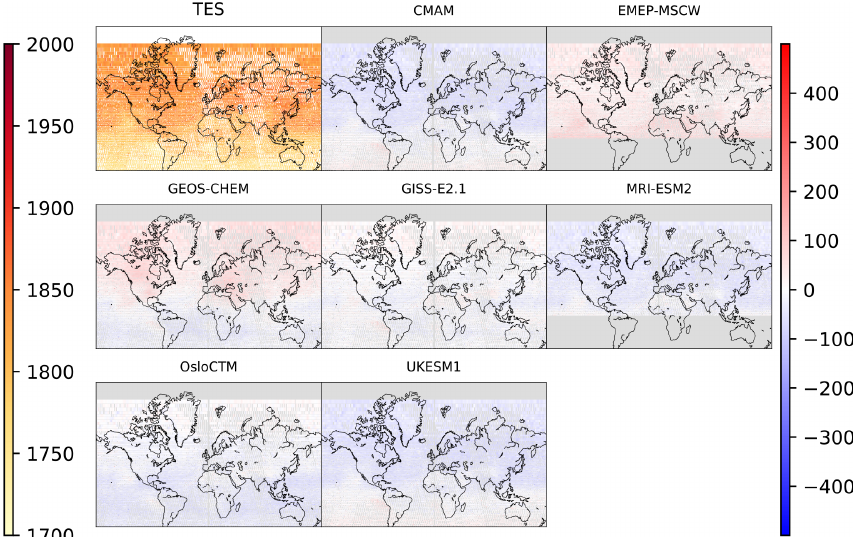
Figure 6. TES measurements (top left) of CH 4 in the mid-troposphere (at 600hPa, ppbv, left color bar) and (remaining panels) model biases for 2008–2009 (model minus measurement, also ppbv, right color bar). Results for 2014–2015 are similar but had less spatial coverage by the satellite. Gray areas have no data (either from the model, TES, or